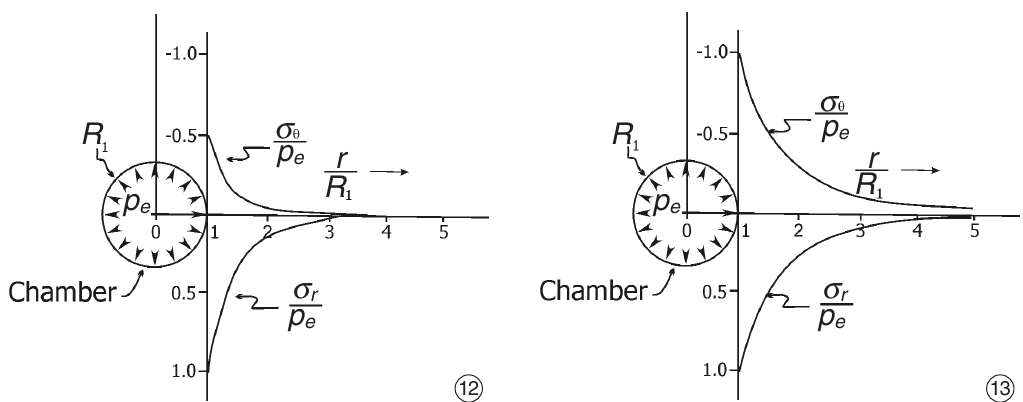
Fig. 12. Decrease in intensity (magnitude) of the tensile circumferential stress σ θ and the compressive radial stress σ r with increasing distance from the margin of a spherical magma chamber subject to an excess magmat- ic pressure p e . The variation is seen in a vertical plane. The stresses are made dimensionless through dividing by the magmatic excess pressure and the distance is made dimensionless by dividing the radius vector r (distance) by the radius of the magma chamber R 1 . Fig. 13. Decrease in intensity (magnitude) of the tensile circumferential stress σ θ and the compressive radial stress σ r with increasing distance from the margin of a (vertical) cylindrical magma chamber subject to an ex- cess magmatic pressure p e . The variation is seen in a horizontal plane. The stresses are made dimensionless through dividing by the magmatic excess pressure and the distance is made dimensionless by dividing the radius vector r (distance) by the radius of the magma chamber R 1